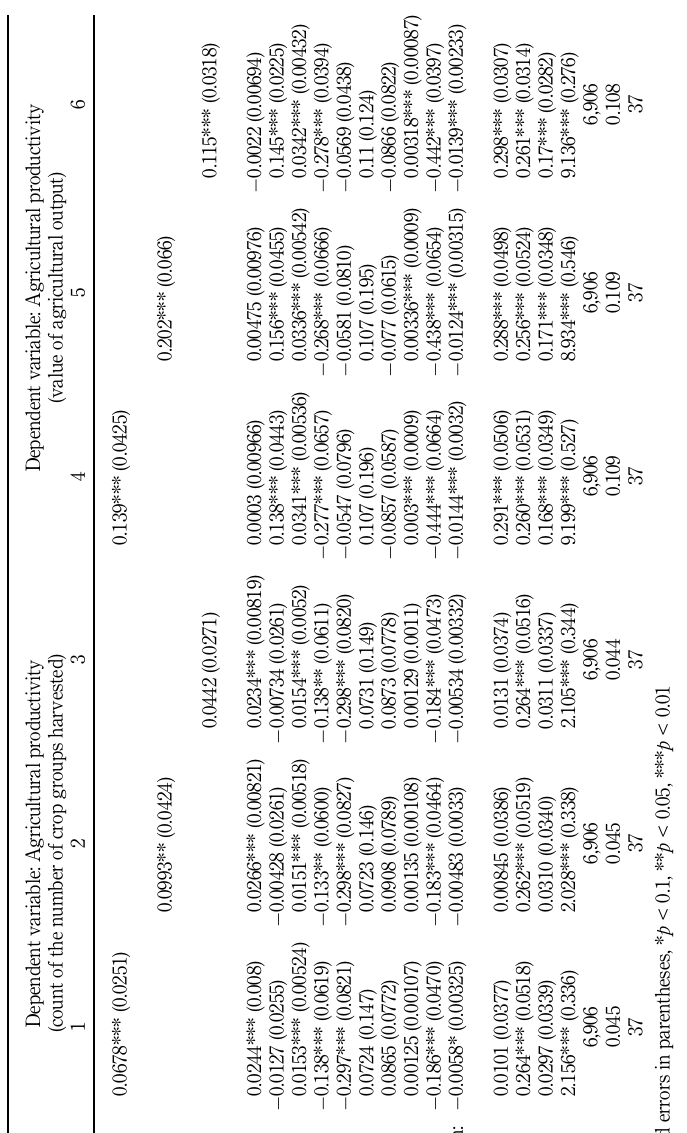
Table 6. Effects of